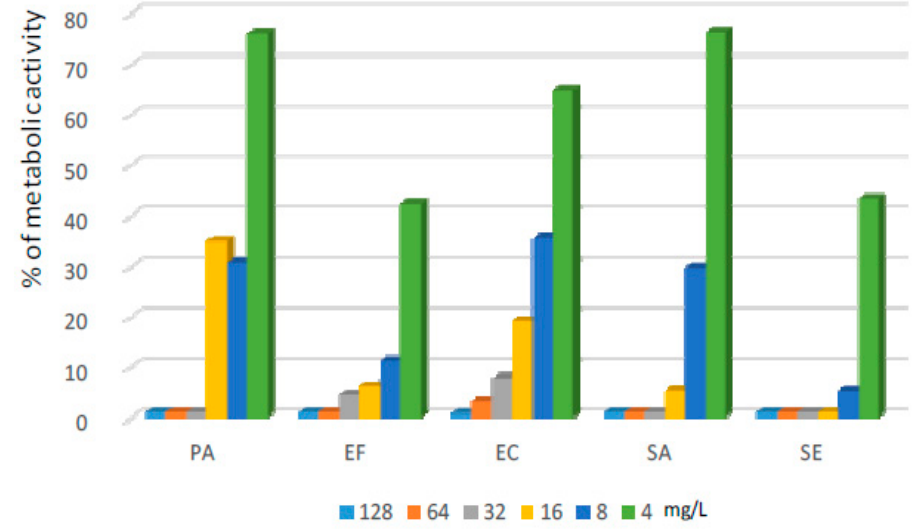
Figure 6. Activity of the lipopeptide applied at concentrations 4–128 mg/L against biofilms formed on CLs. The results are presented as the percentage of metabolic activity in comparison to positive (100%) and negative (0%) controls; RSD ≤ 20%.